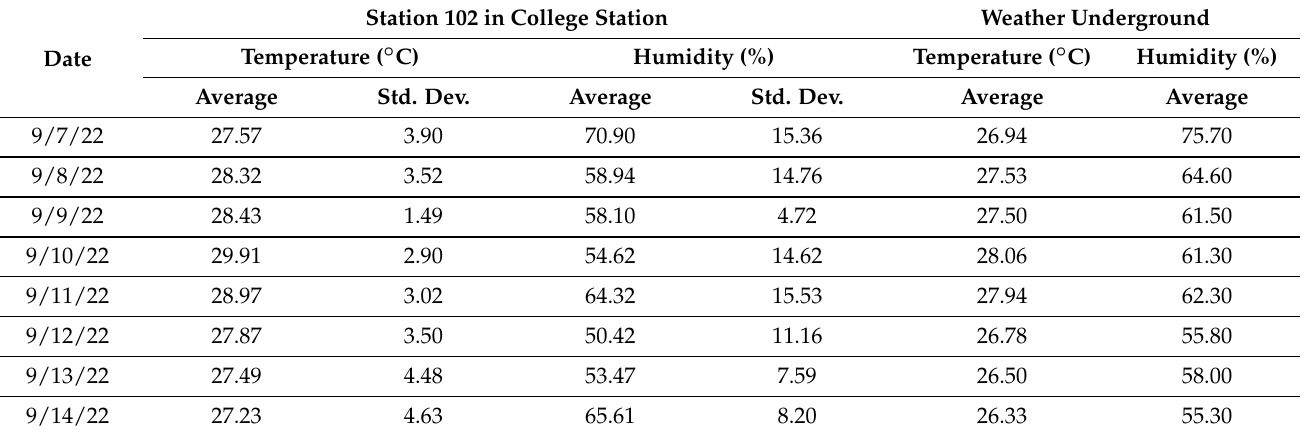
Table 2. Daily record of temperature and humidity for the dates between 7 September and